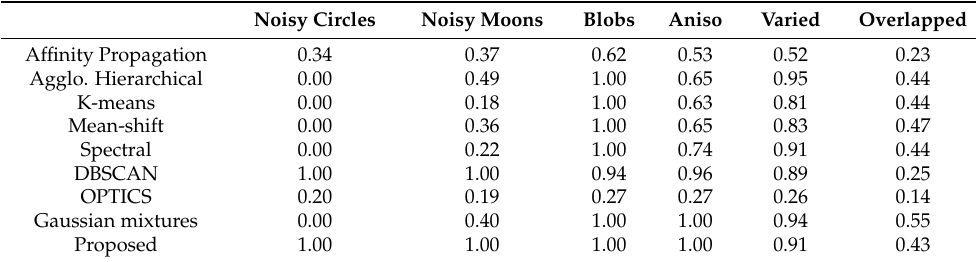
Table 6. The V_measure of affinity propagation, agglomerative hierarchical, k-means, mean-shift, spectral, DBSCAN, OPTICS, Gaussian mixtures, and the proposed clustering methods noisy circles, noisy moons, blobs, anisotropic, varying variance, and overlapping